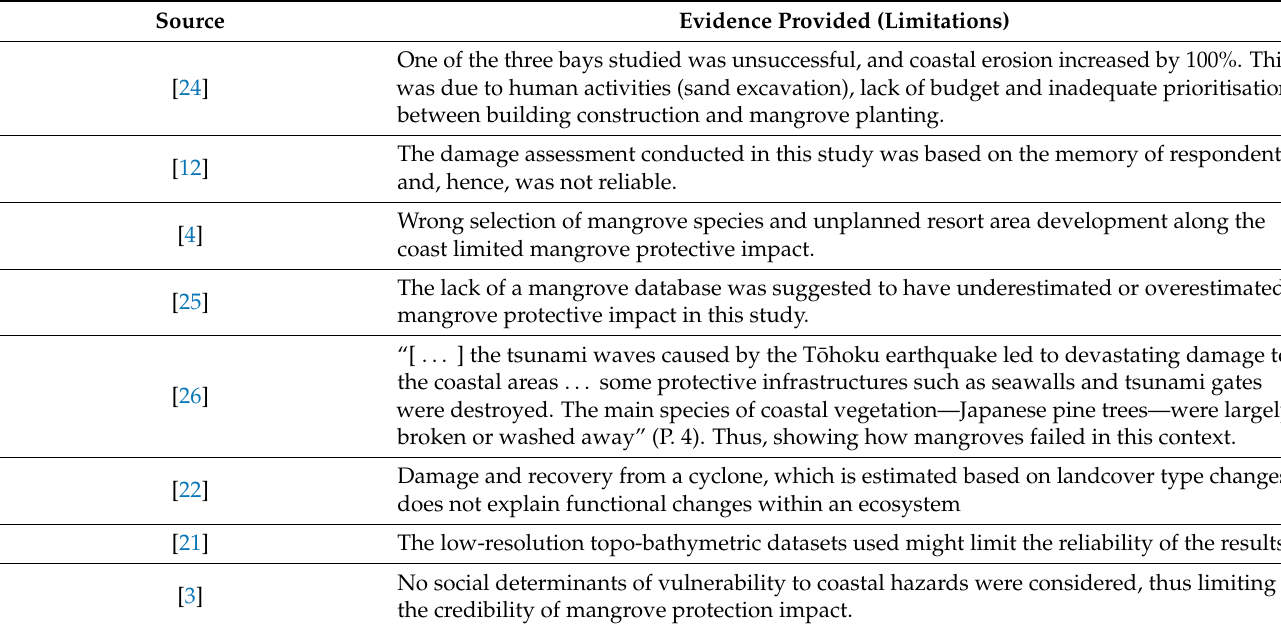
Table 3. Scientific evidence (limitations) from selected studies. Source